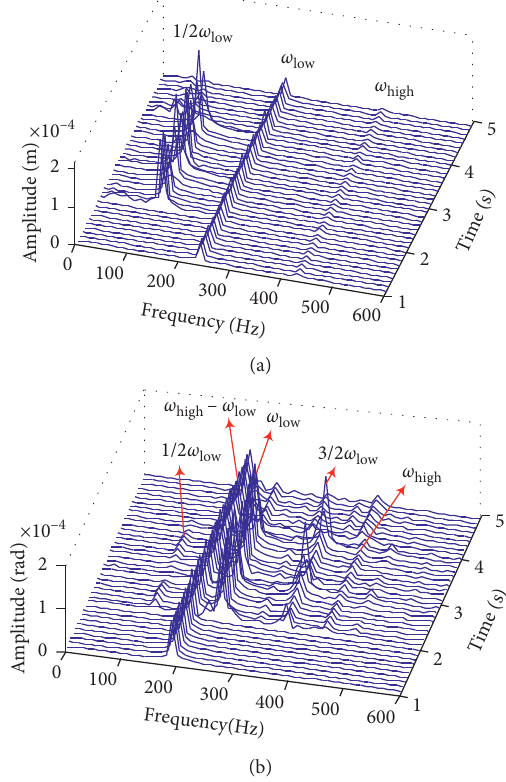
Figure 12: Transient time-frequency waterfall curves of the bending and torsional motions of the rotor system for k r � 1.4 × 107N/m. (a) Bending motion and (b) torsional